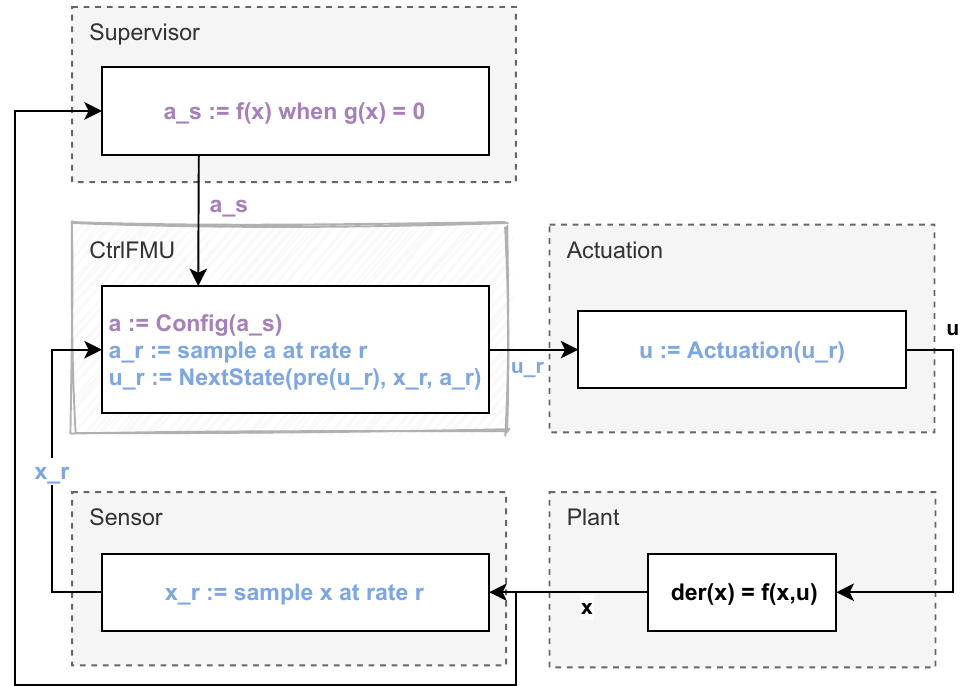
Figure 4. Motivating example with supervisor